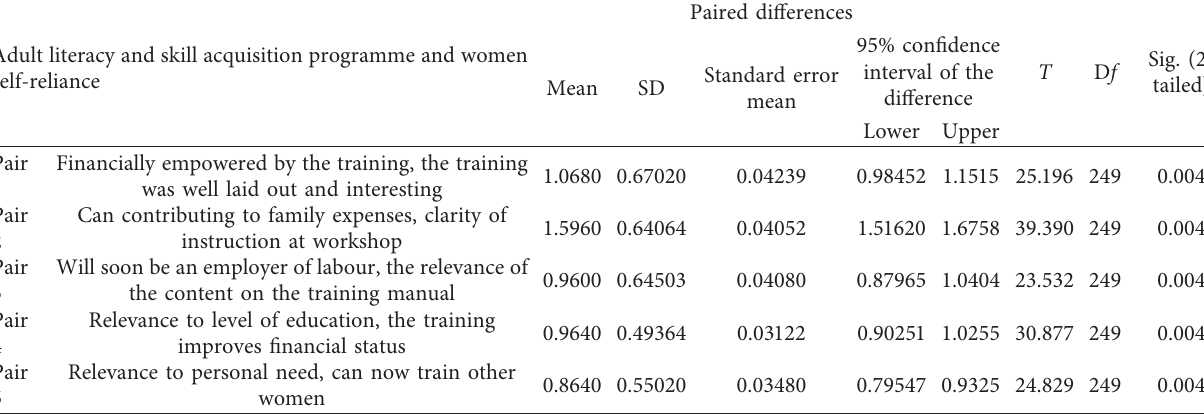
Table 4: Relationship between adult literacy and skill acquisition programme and women self-reliance using paired samples test. Adult literacy and skill acquisition programme and women self-reliance